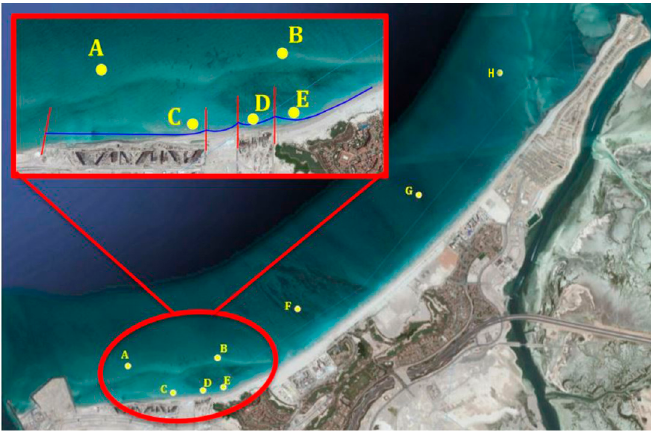
Figure 6. Positions of the virtual buoys along Saadiyat beach.